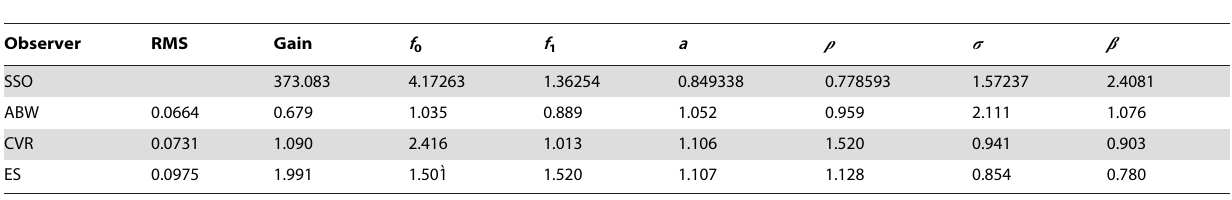
Table 3. SSO parameters before and after estimation from present data.